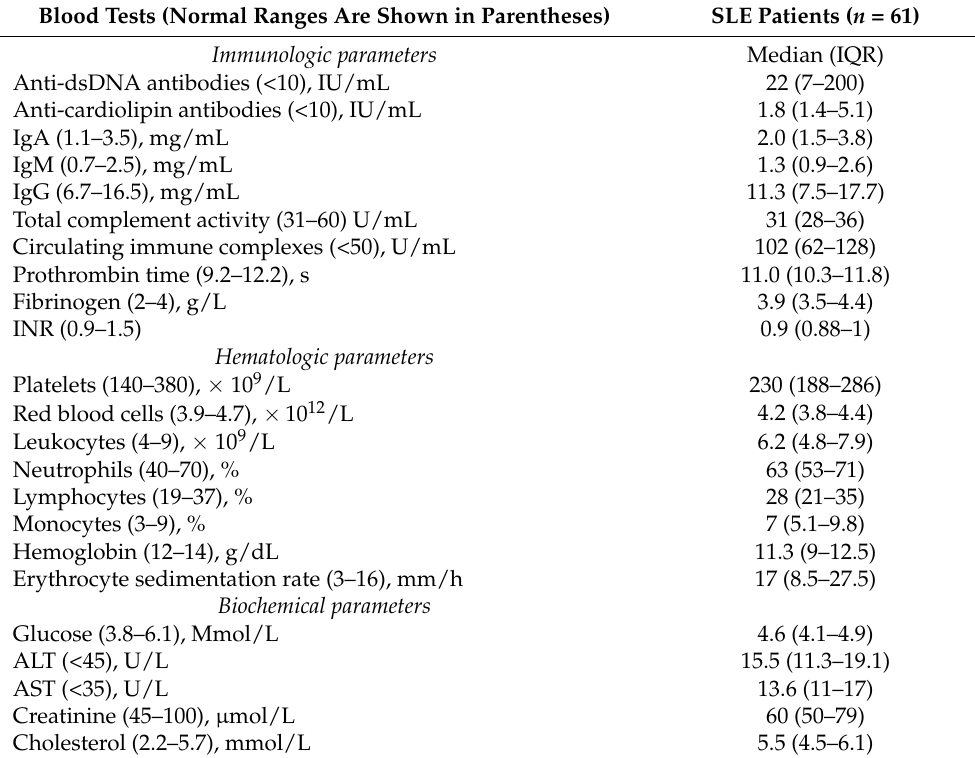
Table 4. Parameters of blood tests in SLE patients enrolled in the study. Blood Tests (Normal Ranges Are Shown in Parentheses) SLE Patients ( n = 61) Immunologic parameters Median (IQR) Anti-dsDNA antibodies (<10),